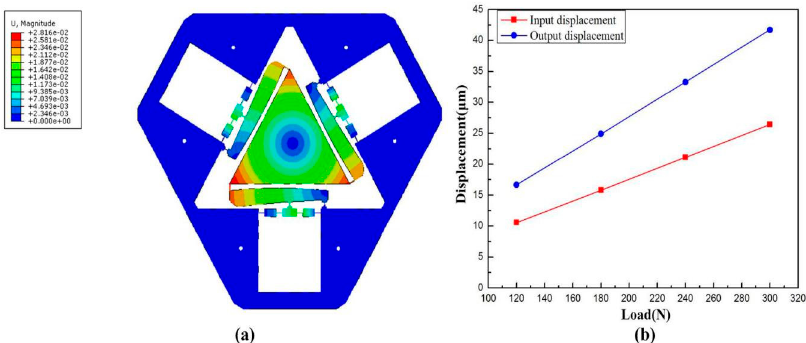
Figure 15. ( a ) Deformation behavior and ( b ) the input–output displacement relationship of the level model.